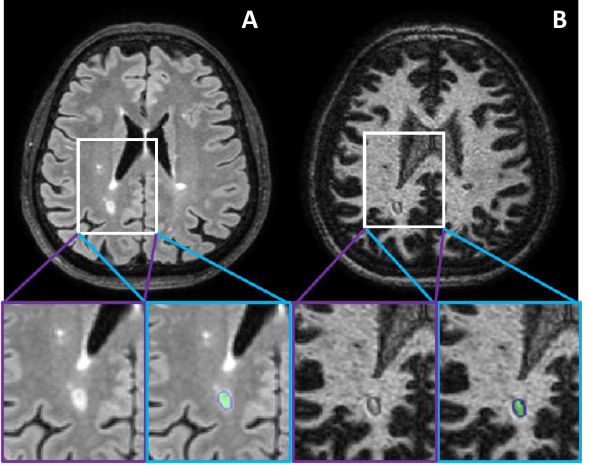
Figure 2. Illustrative FLAIR ( A ) and WM-DIR ( B ) images at 3.0 T of segmentation of the core of DRL with a 2-pixel-disk dilatated element to cover the dark rim.